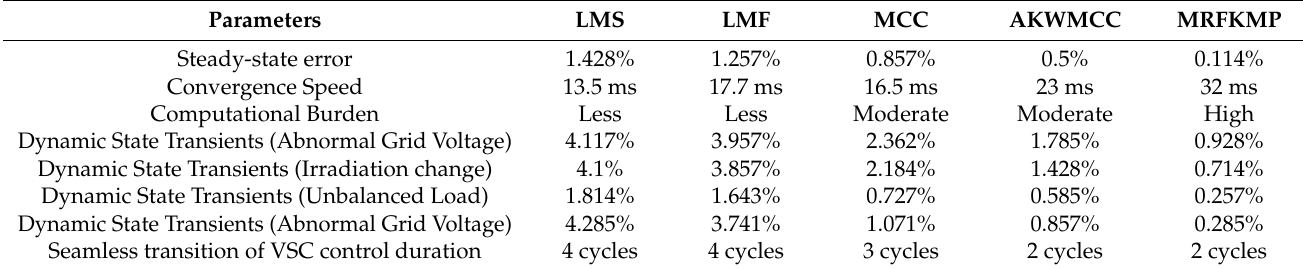
Figure 17. Comparison of w avg with LMS, LMF, MCC, AKWMCC and MRFKMP-based VSC control. The LMS delivers high steady-state error as compared to LMF. The MCC and AKWMCC present almost similar weights; AKWMCC shows fewer variations as compared to MCC during steady-state and dynamic conditions. The MRFKMP-based VSC control delivers the more accurate weight signals with reduced variations during abnormal grid voltage and load unbalancing, and it results in reduced overall losses in the system and provides better efficiency. The comparative analysis of the proposed control with LMS, LMF, MCC, AKWMCC and MRFKMP is shown in Table 2. Table 2. Comparative performance analysis of the VSC